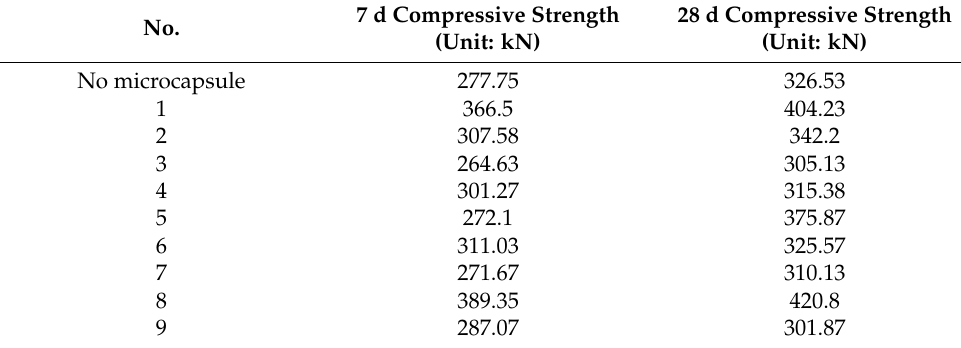
Table 4. Ultimate compressive strength of